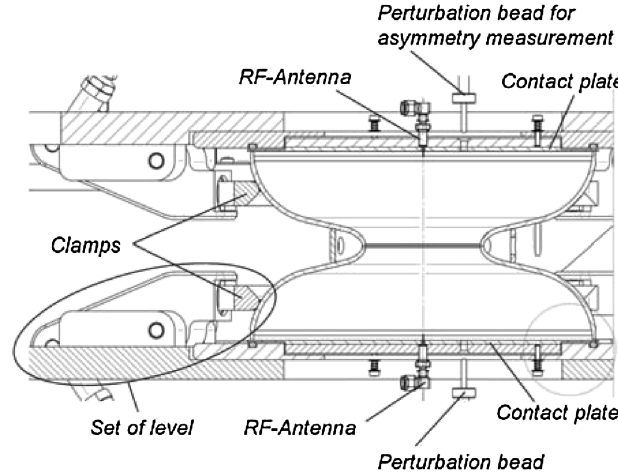
FIG. 8. (Color) Simple rf-measurement device with clamped dumbbell. FIG. 9. Covered dumbbell in clamped